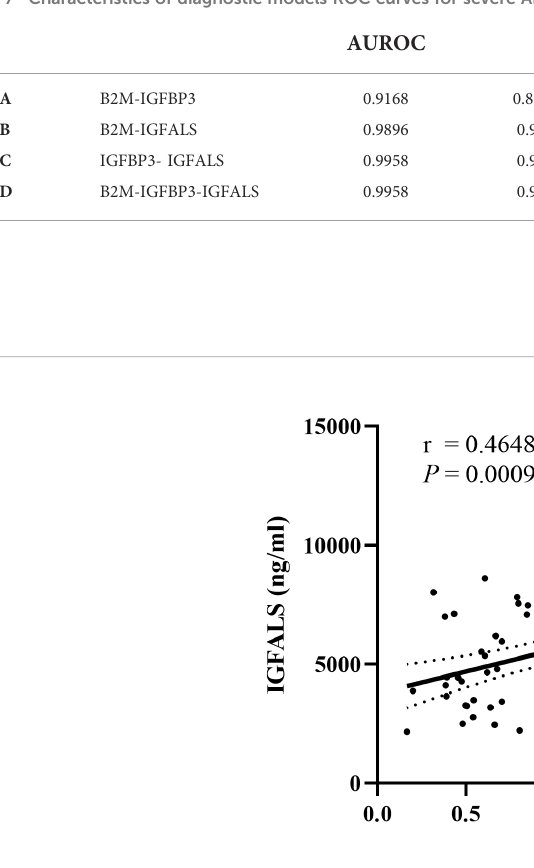
TABLE 7 Characteristics of diagnostic models ROC curves for severe ALD.